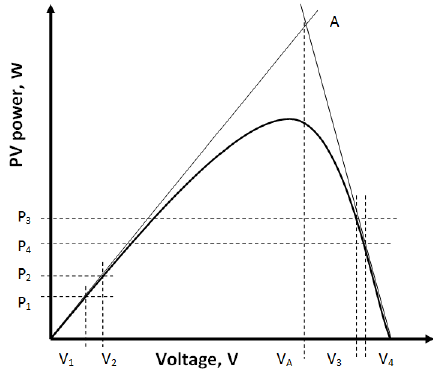
Figure 3. Straight line approach to find the MPP.